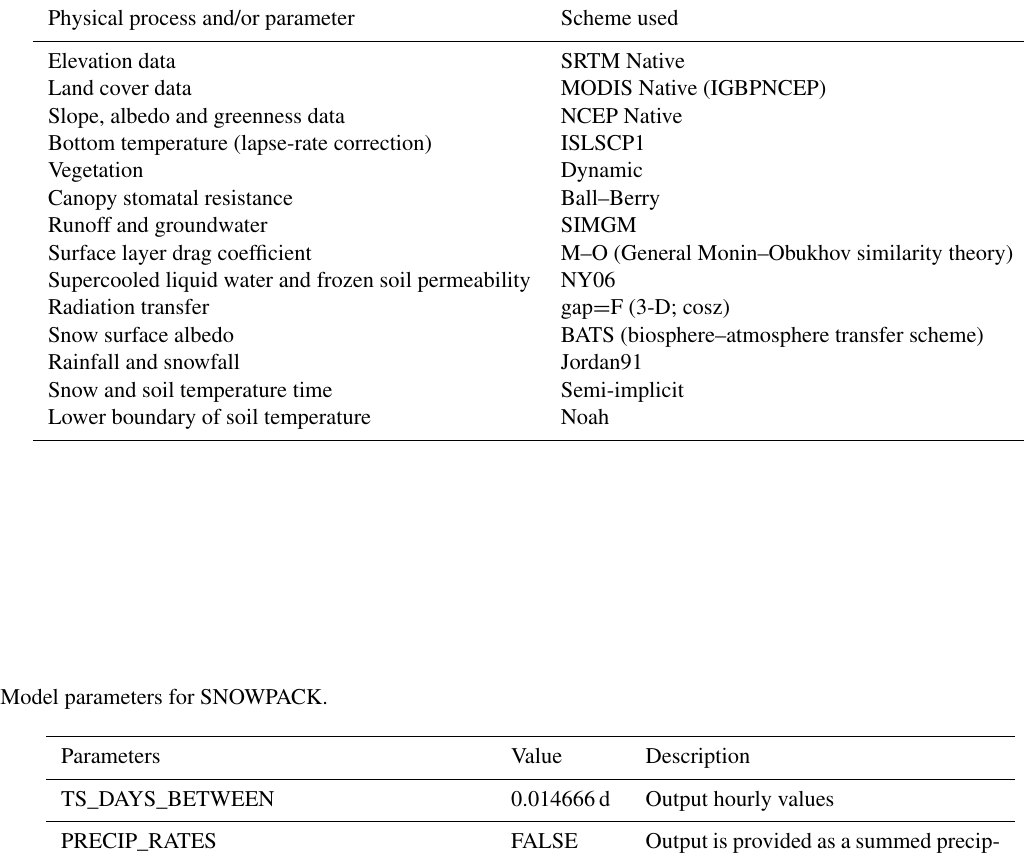
Table A1. Noah-MP v3.6 physical parametrization scheme options utilized in this study.